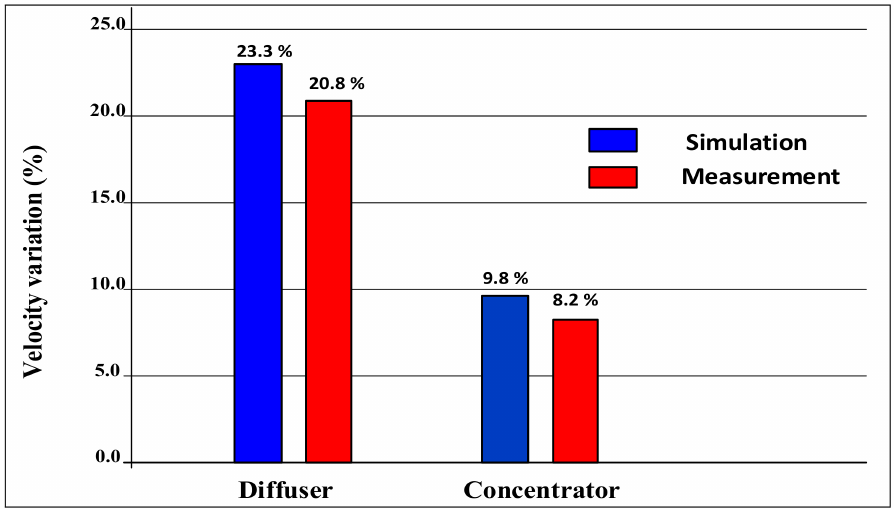
Figure 15. Comparison of velocity variations.